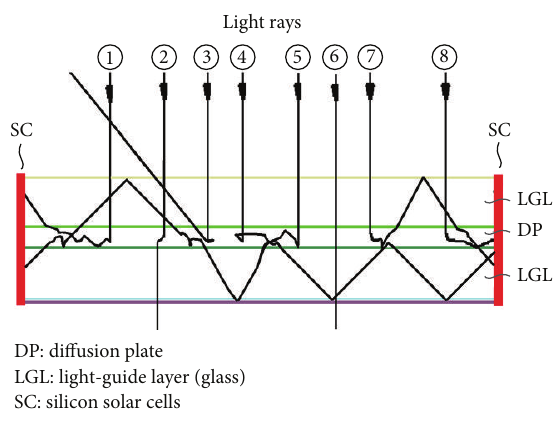
Figure 2: Schematic illustration of the basic structure of a diffusive solar cell window as well as various mechanisms of light transport inside.